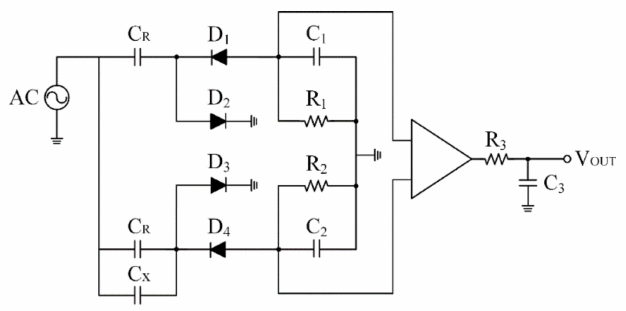
Figure 3. Schematic of the adopted